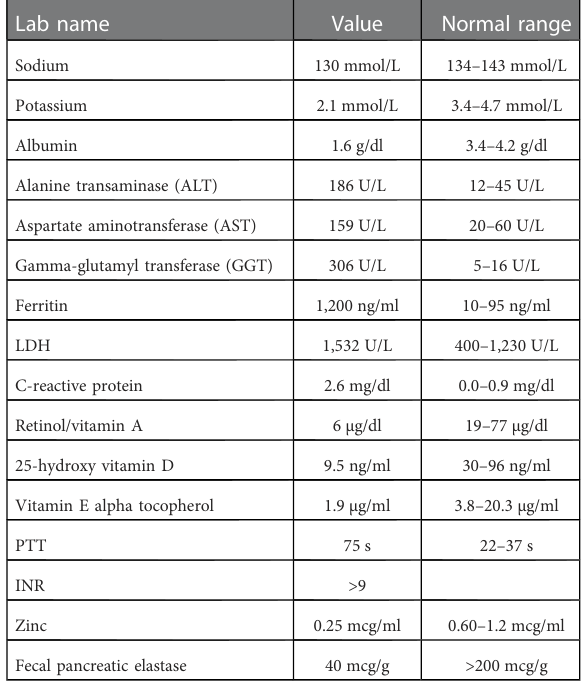
TABLE 1 Labs values at the time of presentation with normal reference